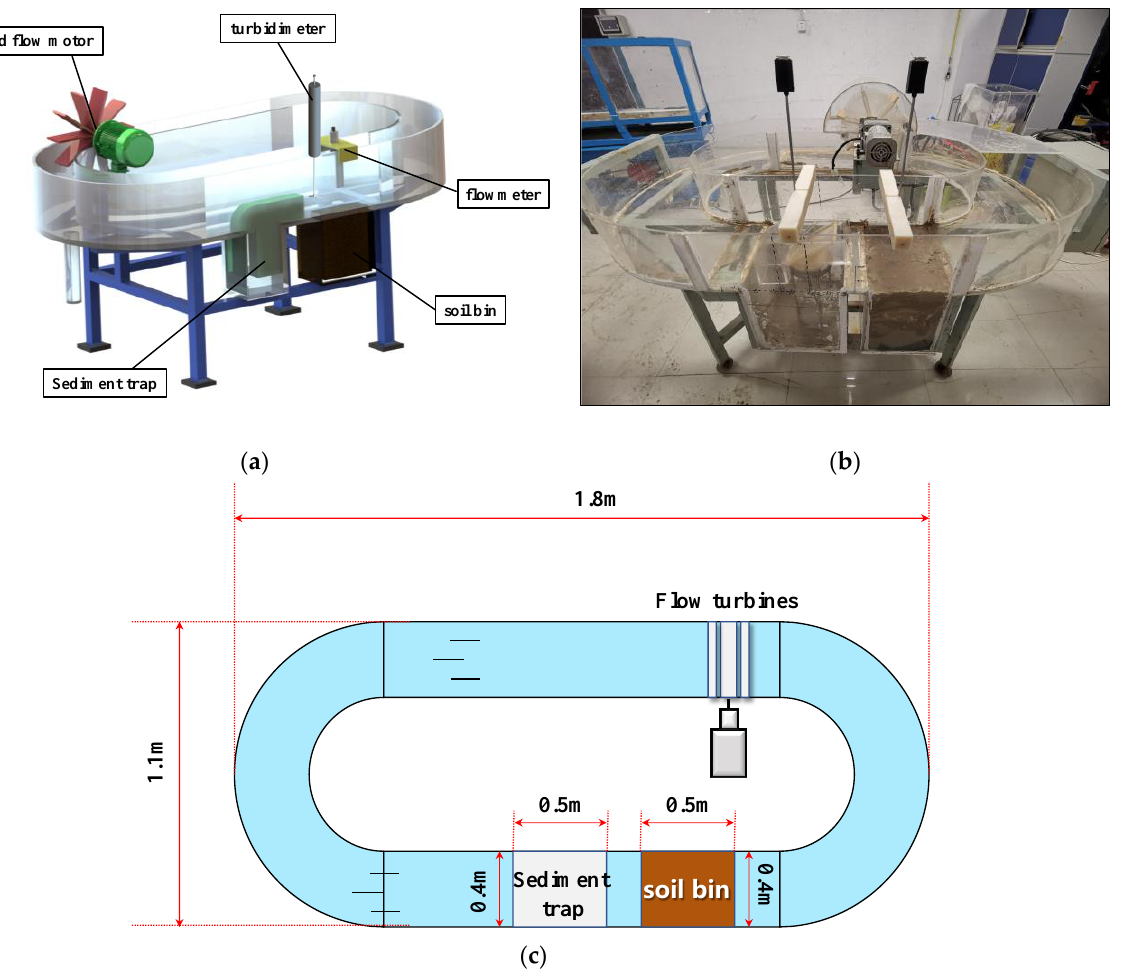
Figure 5. ( a ) Main structural design of the water flume; ( b ) Description of what is contained in the second panel; ( c ) Flume diagram.